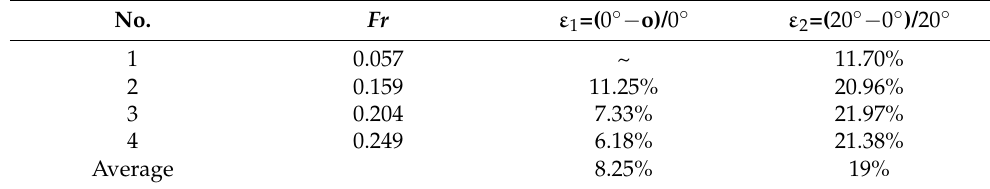
Figure 9. Resistance test data at a different Froude number Fr. Table 4. The resistance increment ratio of model tests with fins at different speeds (o = without).